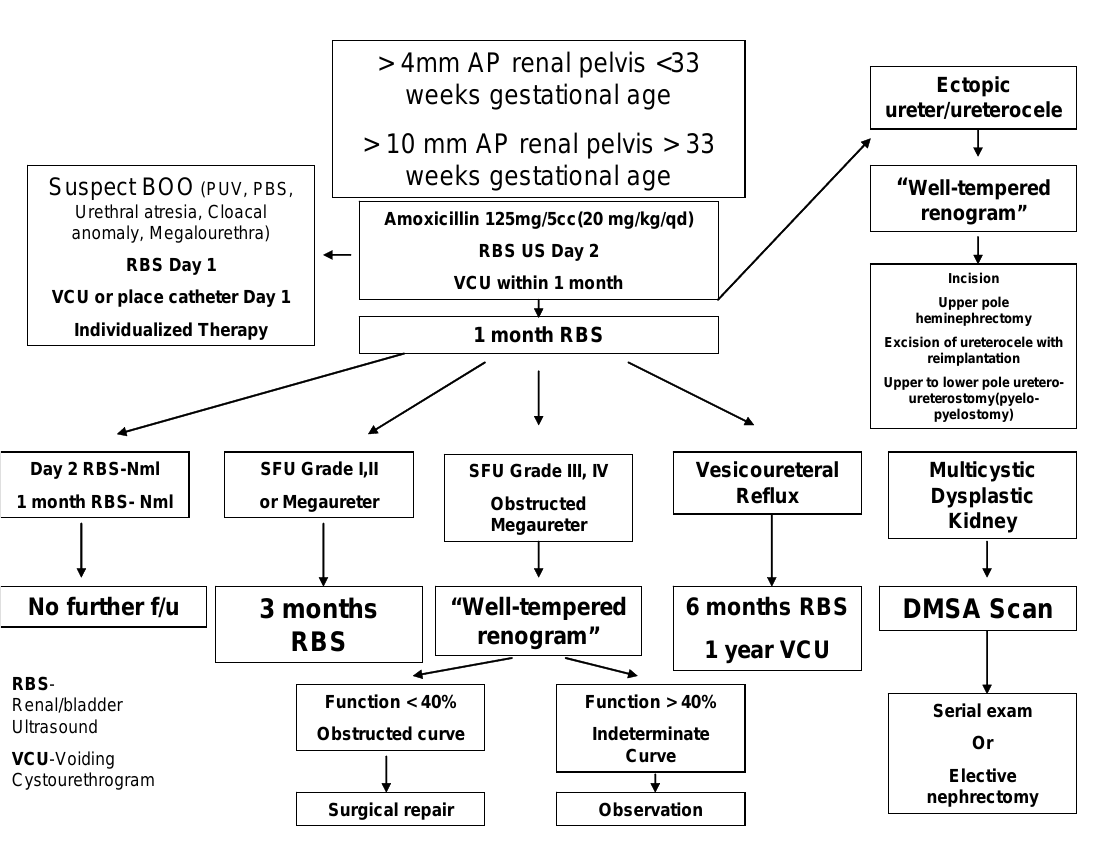
FIGURE 2. Postnatal evaluation of